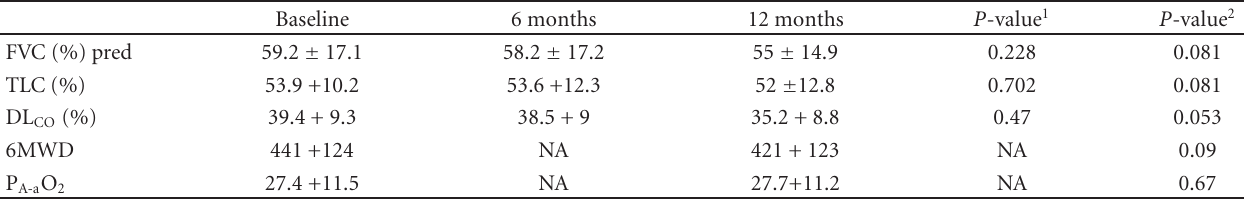
Table 2: FVC, TLC, DL CO , 6MWD, and P A-a O 2 at baseline and 6 and 12 month after MMF treatment.